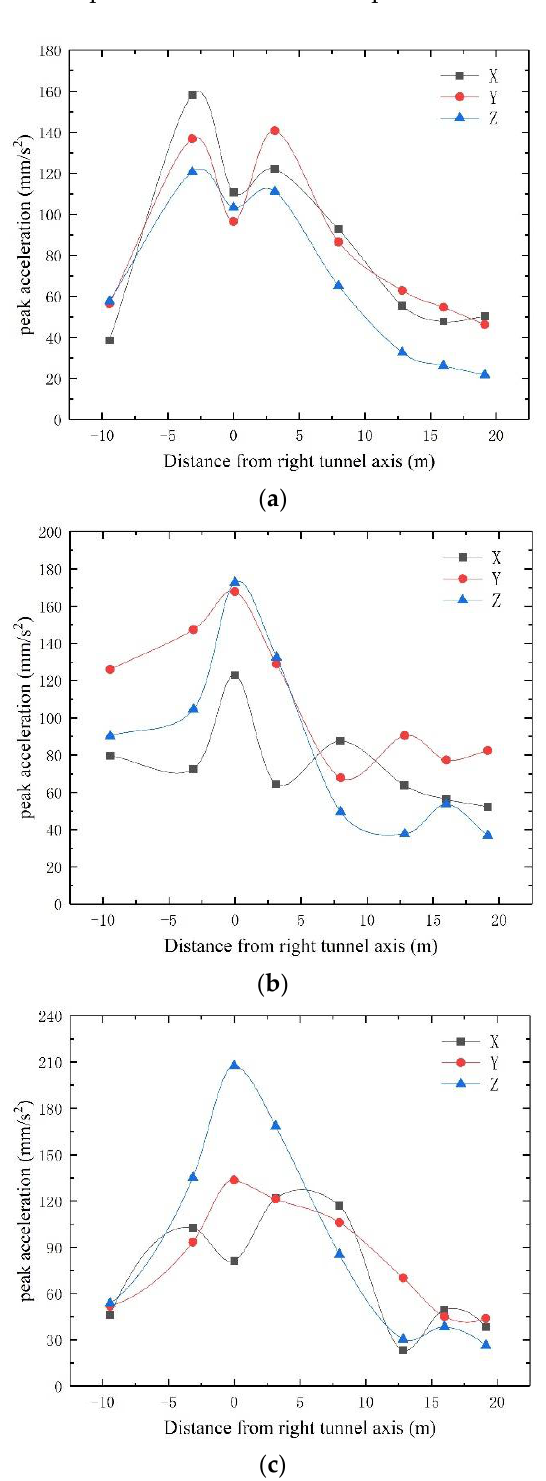
Figure 9. Transverse influence trend with different buried depths. ( a ) 0 m depth; ( b ) 10 m depth; ( c ) 20 m depth.